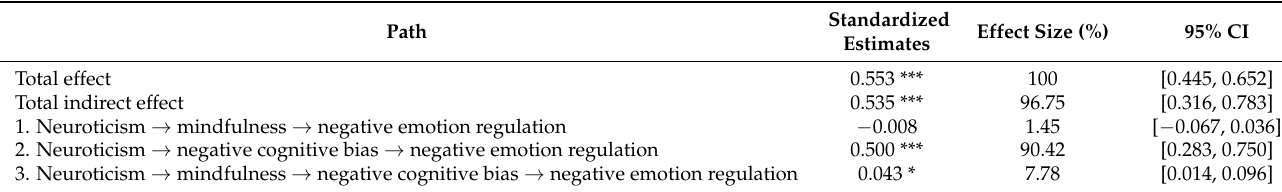
Table 2. Bootstrap analysis of the mediation effects in the chain mediation model. Path